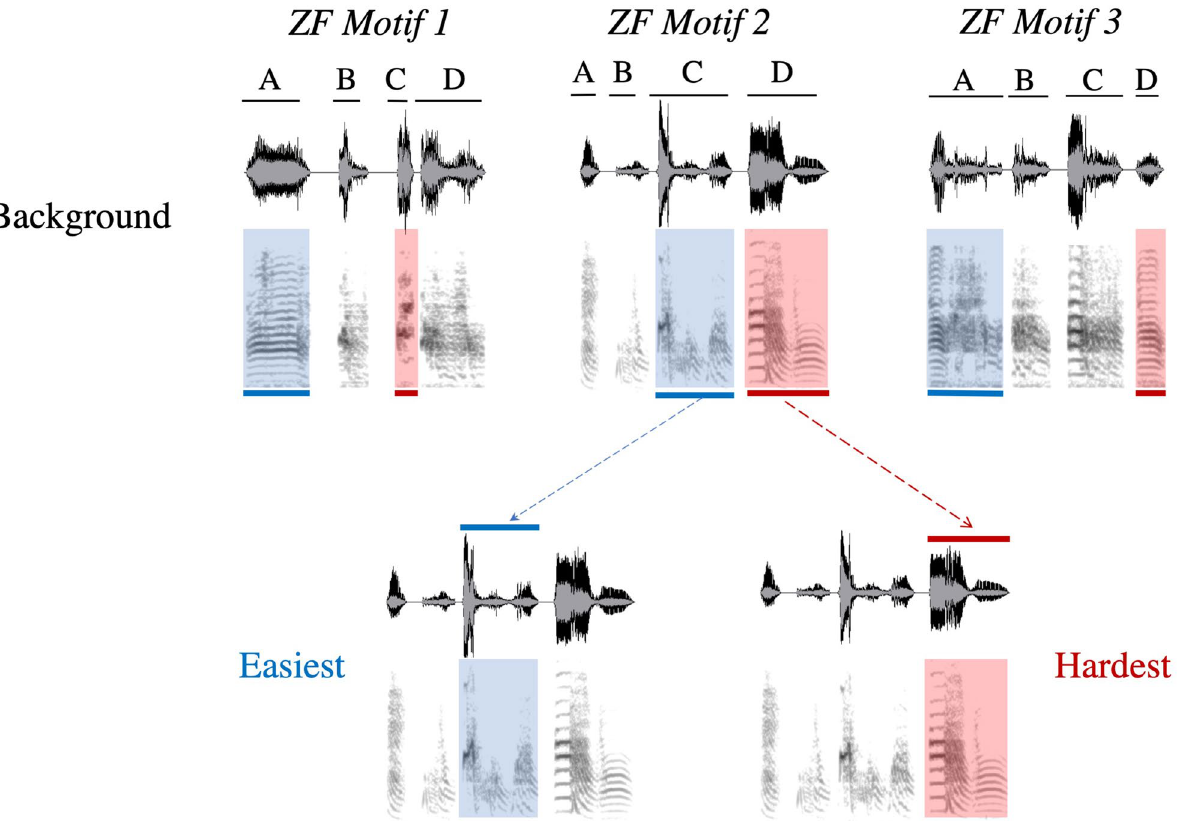
Figure 2. Time waveform (top) and spectrogram (bottom) for each background stimulus used for each of the three male’s motifs used in this experiment (made in Sonic Visualiser 51 ). For each motif, the syllables are indicated ( A – D ) based on their position in the motif. For each motif, the syllable rendition that was easiest across birds is highlighted in blue and the syllable that is the hardest is indicated in red. For ZF Motif 2, the spectrograms and time waveforms for the easiest and hardest syllable rendition targets are depicted below the background stimulus. Note that while the spectrogram and time waveform are useful for visualizing the acoustic differences between types of syllables, they do not capture the rendition-to-rendition acoustic variation that zebra finches are so easily able to